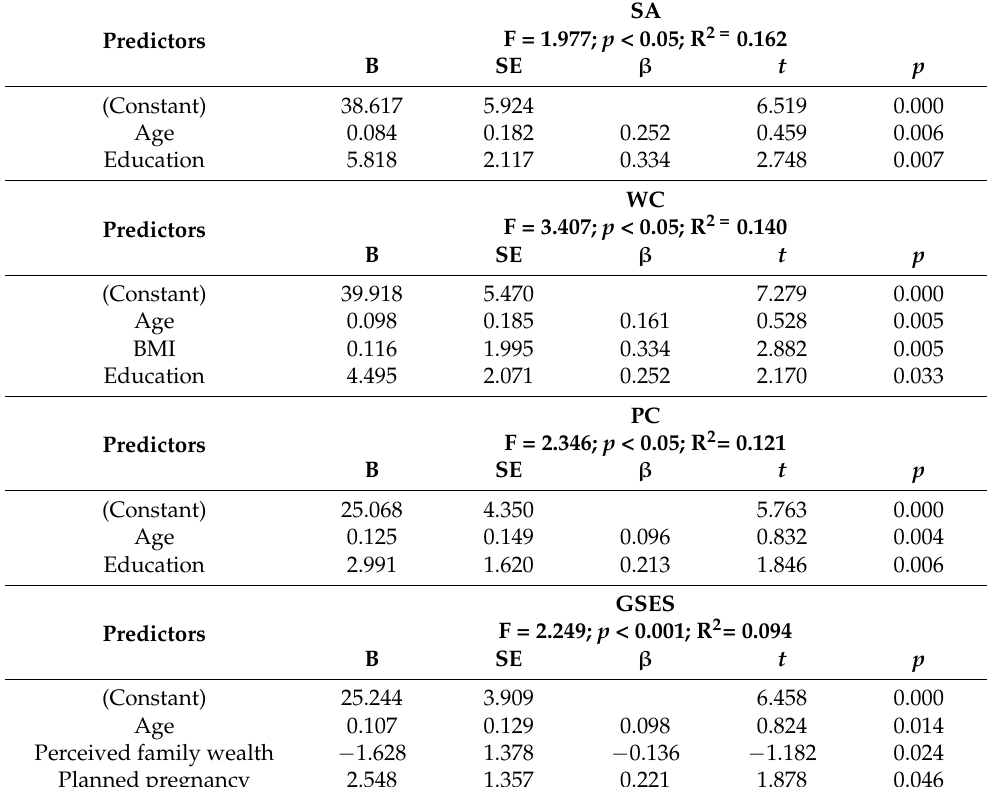
Table 3. Regression analysis for body evaluation and self-efficacy in women with gestational diabetes